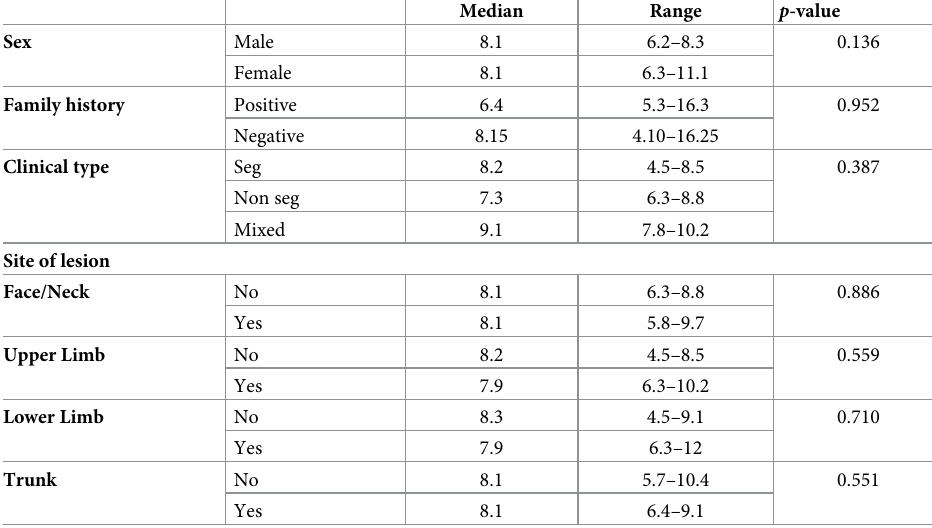
Table 3. Differences in TNF- α serum level (pg/ml) in relation to clinical data in vitiligo